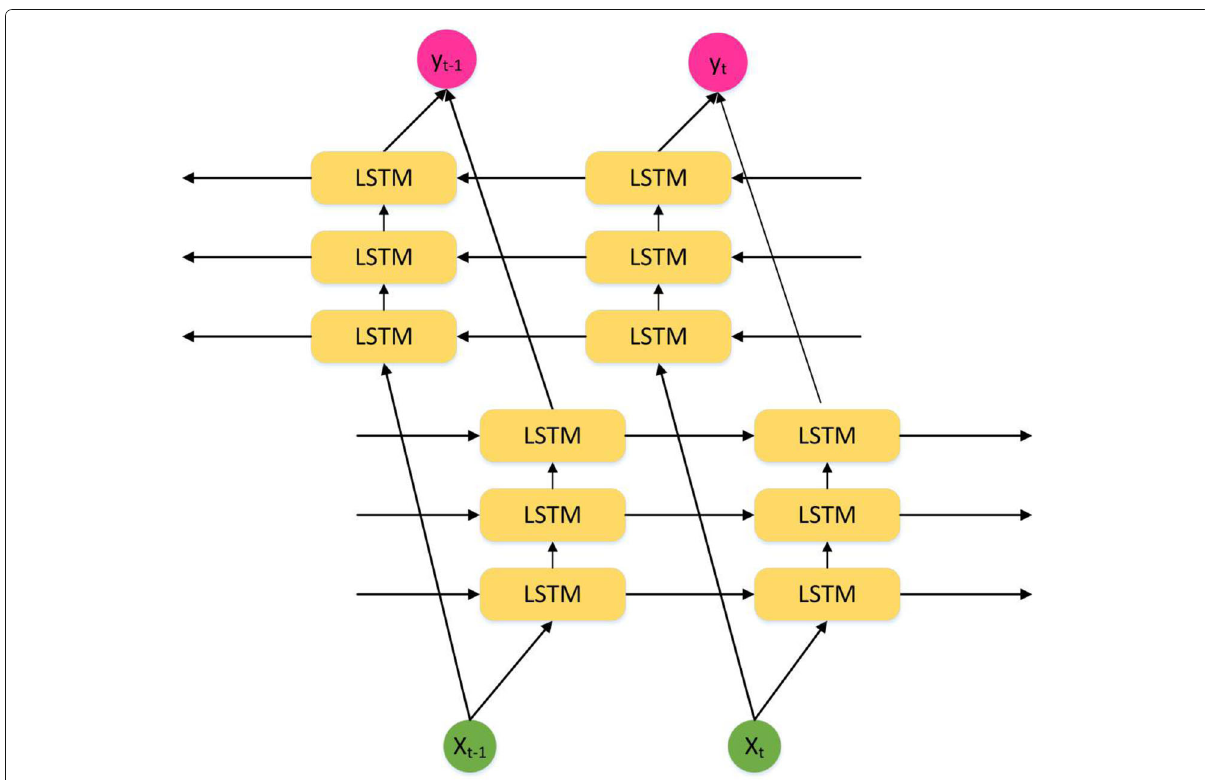
Fig. 3 BRNN-LSTM with three LSTM